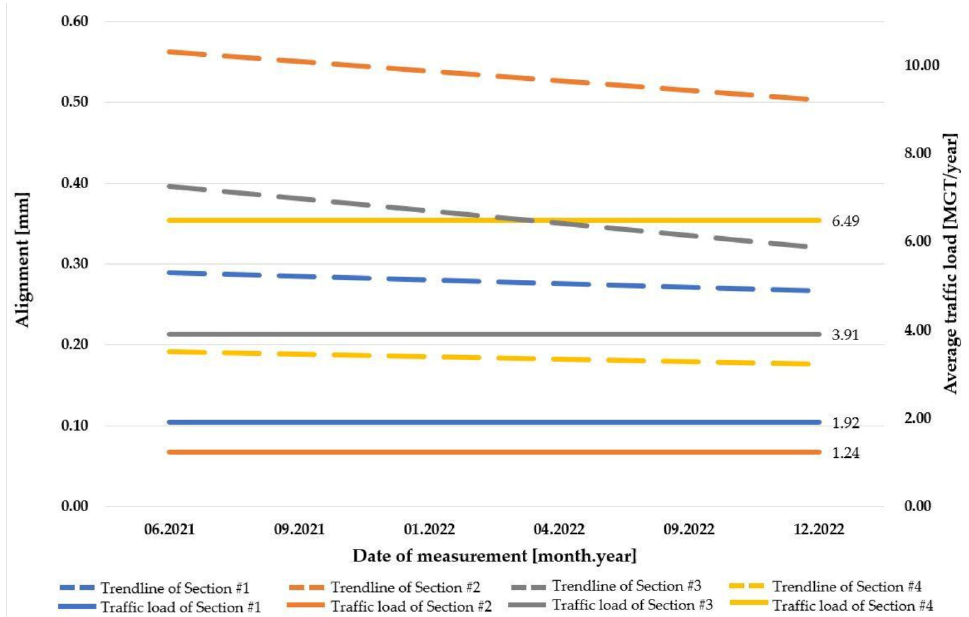
Figure 25. The relationship between alignment and traffic load in ballasted track systems.